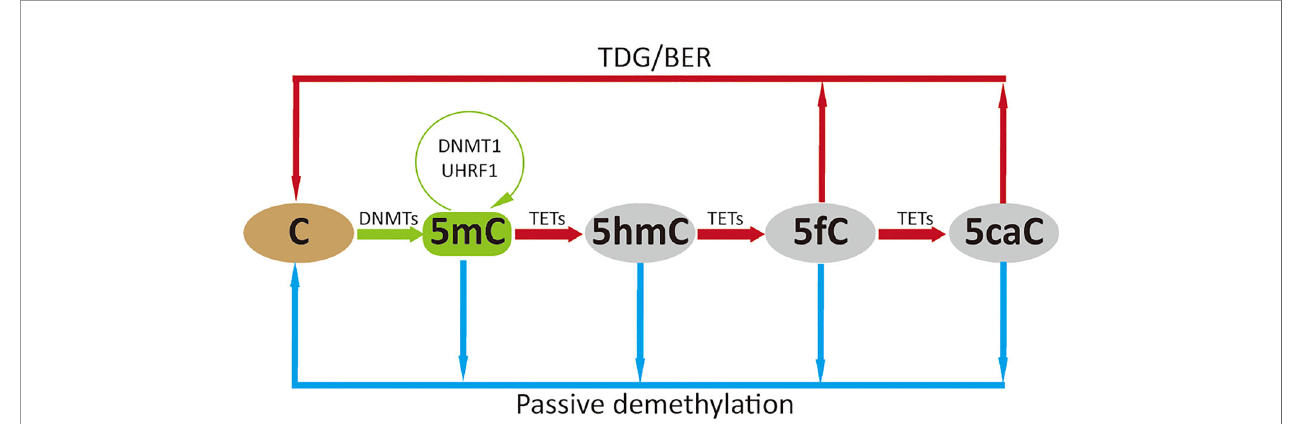
FIGURE 1 | DNA methylation cycle. DNMTs catalyze the addition of a methyl group to the fi fth carbon position of cytosine to generate methylated cytosine (5mC), which is maintained by DNMT1 (green arrow); 5mC is oxidized to 5-hydroxymethylcytosine (5hmC), which can be further oxidized to 5-formylcytosine (5fC) and 5-carboxylcytosine (5caC) by TETs. The higher oxidized cytosine bases 5fC and 5caC can then be converted back to their unmodi fi ed state directly by thymine DNA glycosylase (TDG) and subsequently base excision repair (BER) processing; these oxidative steps contribute to active demethylation (red arrow). Passive demethylation removes 5mC from all forms of methylcytosine due to absence or reduction in DNMT levels and function (blue